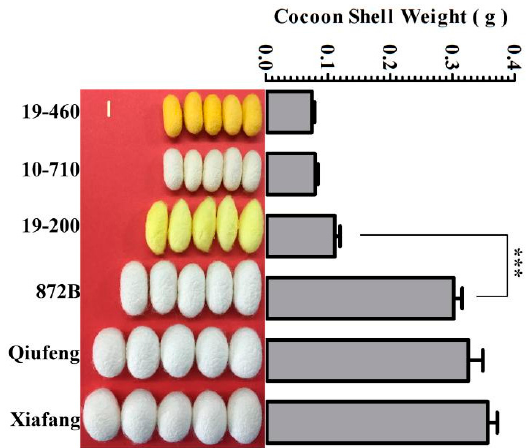
Table 3. Summary of the sequence assembly after lllumina sequencing.